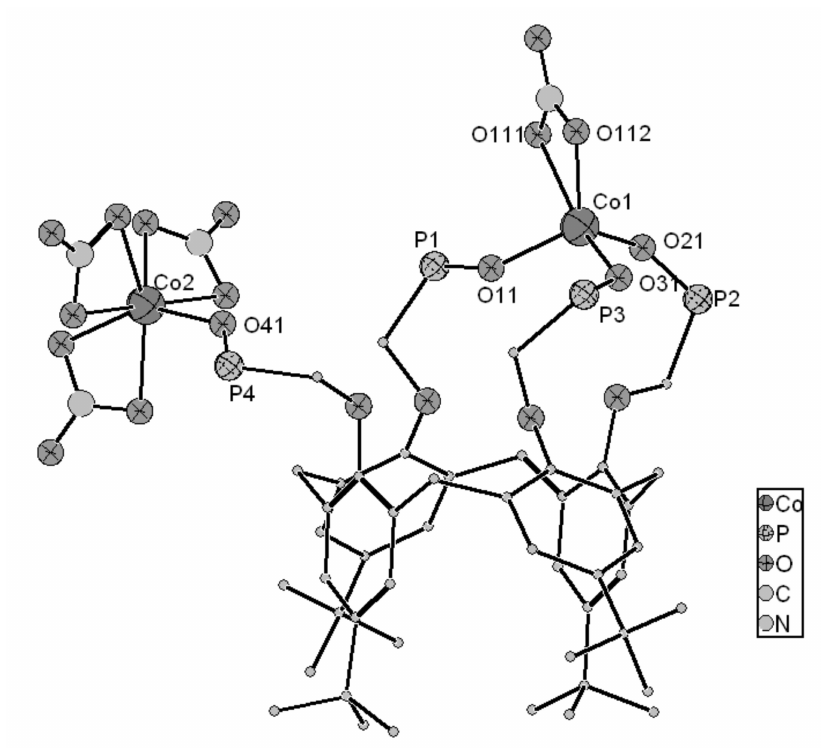
Figure 5. The crystal structure of the [Co 2 (NO 3 ) 4 L] complex. Reprinted with permission from Ref. [16], 2010, Kostin G.A. All hydrogen atoms and butyl substituents on phosphorus atoms were omitted for